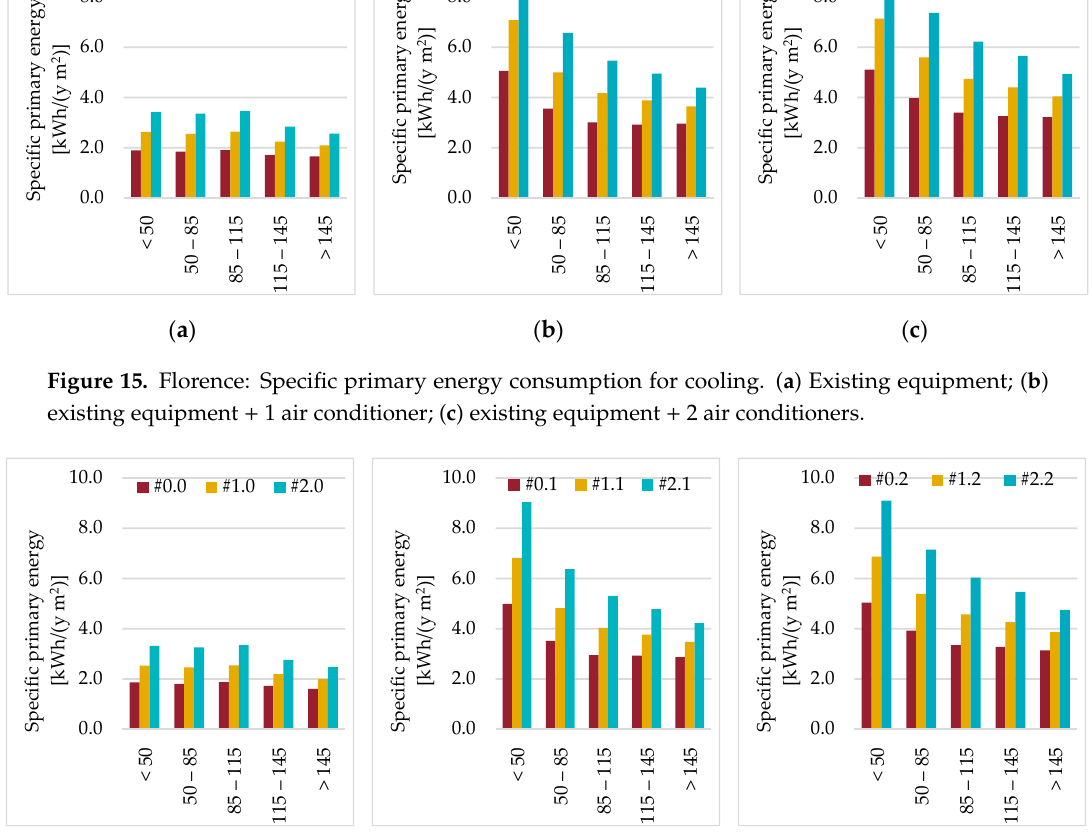
Figure 16. Rome: Specific primary energy consumption for cooling. ( a ) Existing equipment; ( b ) existing equipment + 1 air conditioner; ( c ) existing equipment + 2 air conditioners.